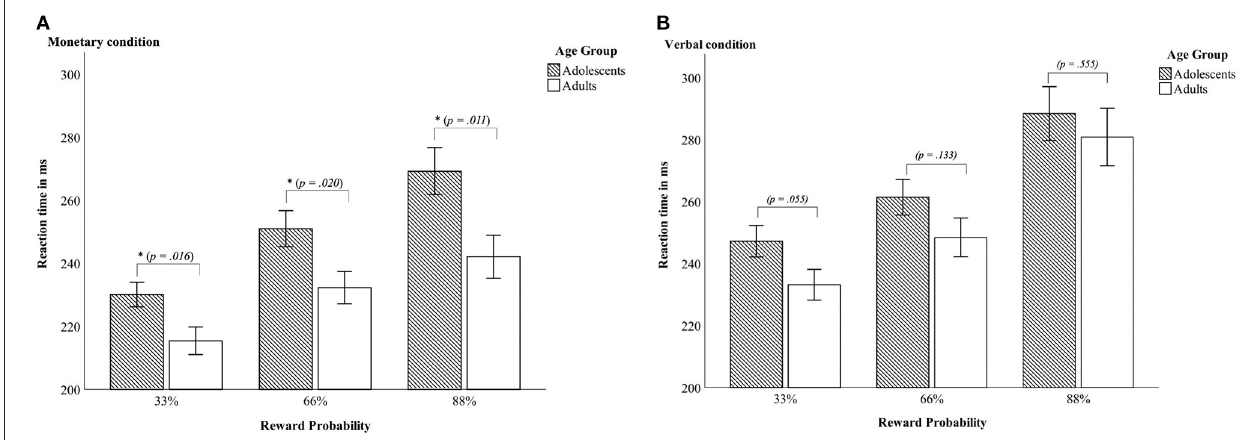
FIGURE 2 | Reaction times—Interaction between age group x reward probability in the monetary condition (A) and in the verbal condition (B) . Error bars denote ± 1 SE. * p ≤ 0.05.